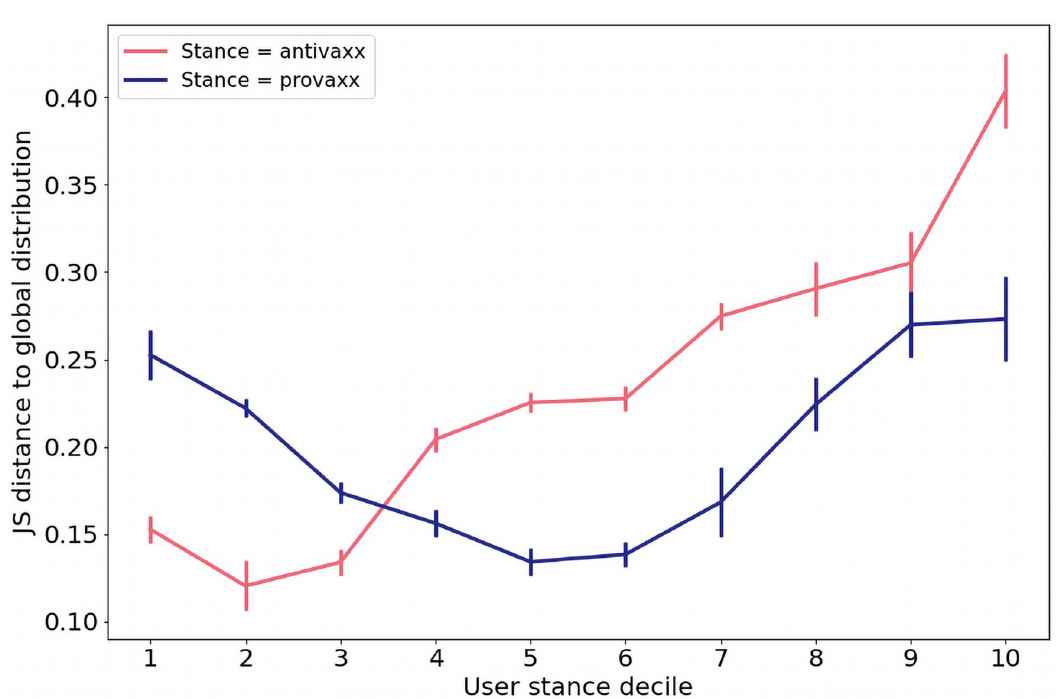
Fig 6. Profiles that express fringe vaccine sentiments are also exposed via their interaction networks to sources of information that are highly dissimilar to link frequencies in the overall discussion. Here we consider users who posted a minimum of 5 tweets containing vaccine-related keywords, and partition them into deciles based on their tweets’ mean probability of expressing anti- and pro-vaccine sentiment. For each such decile and vaccine stance, the plot shows the Jensen-Shannon distance between the frequencies at which links from the domains shown in Fig 2 are shared in the vicinity of users in that decile, and in the interaction network overall. The error bars are computed using a bootstrap technique in which users in the target stance-decile combination where randomly sampled with replacement and the JS-distance to the overall distribution calculated. The error bars depict the standard deviations of each 1000 such